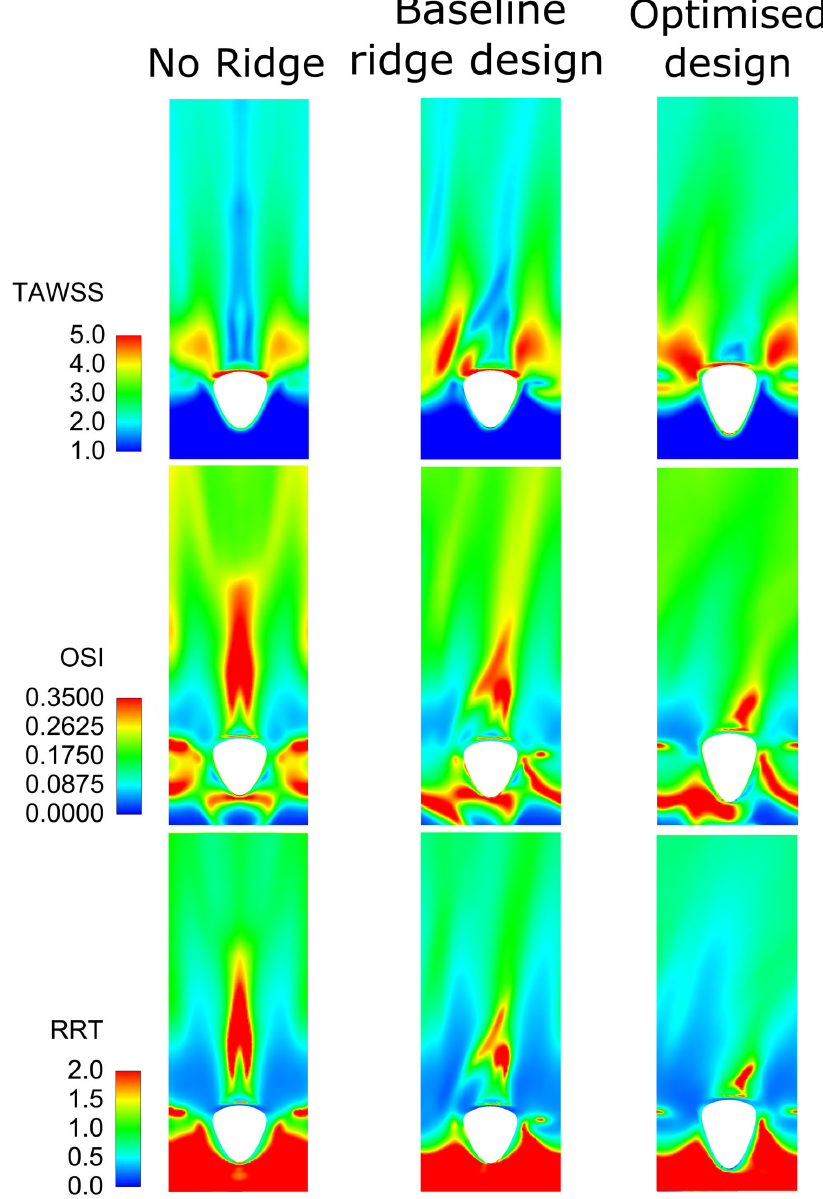
Figure 7. Wall shear stress derived metrics of TAWSS, OSI, and RRT for the reference, baseline ridge design, and optimised design of the current work.